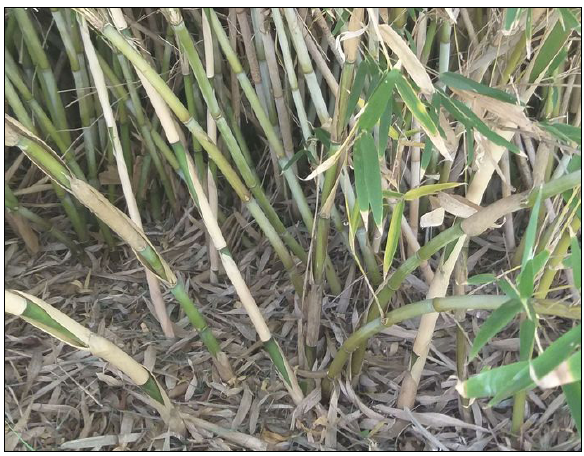
Image: SANBI 39 under licence CC-BY-NC Figure 2: Thamnocalamus tessellatus – an indigenous South African bamboo species.